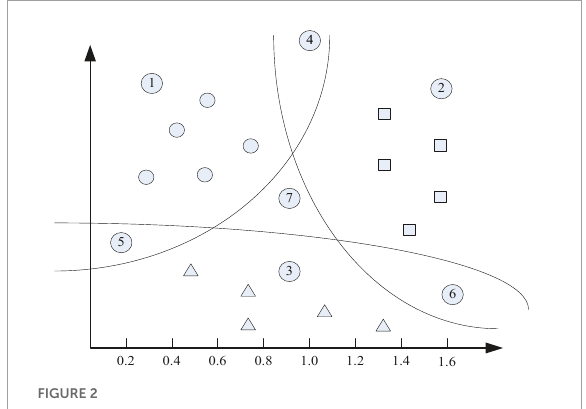
FIGURE2 Example of a multi-classification problem.